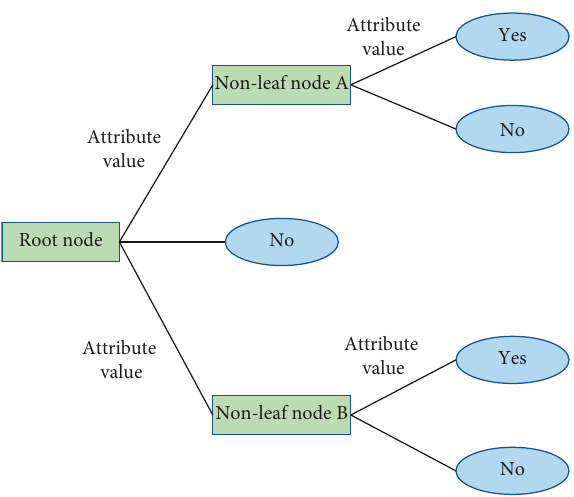
Figure 4: Flowchart of the decision